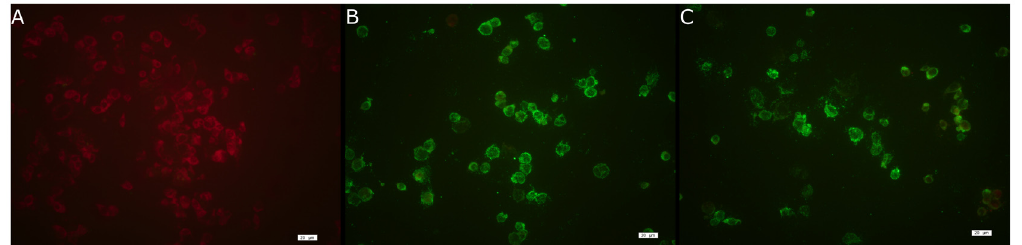
Figure 1. Yellow fever virus (YFV) immunofluorescence in C636 cells. ( A ) Control cells without virus, ( B ) cells infected with YFV 377 H and ( C ) cells with YFV127 P. Green fluorescence depicts YFV in cells marked with a monoclonal YFV antibody conjugated goat anti-mouse IgG labeled with fluorescein FITC.